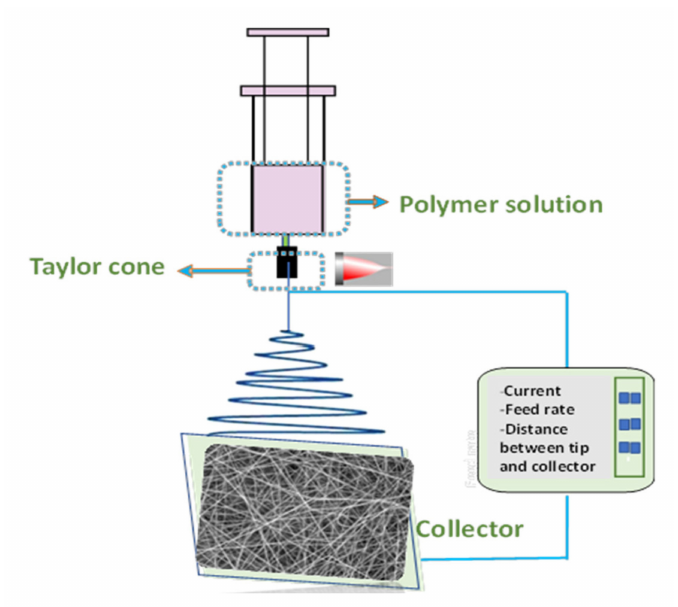
Scheme 1. Representative schematic diagram of the electrospinning machine used in this